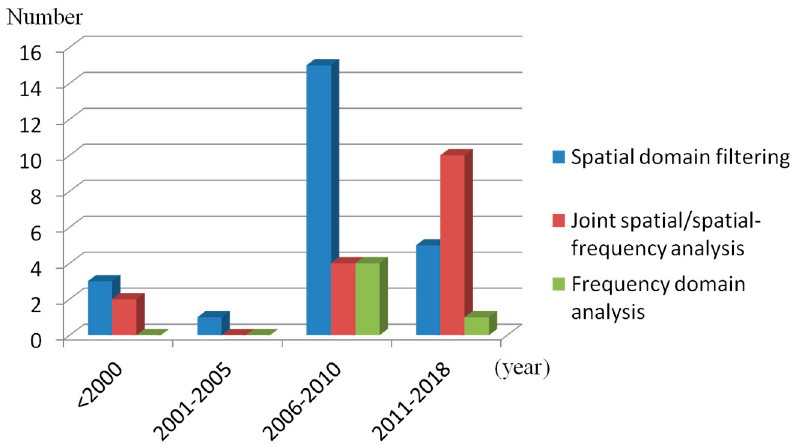
Figure 10. Distribution of filtering detection methods.